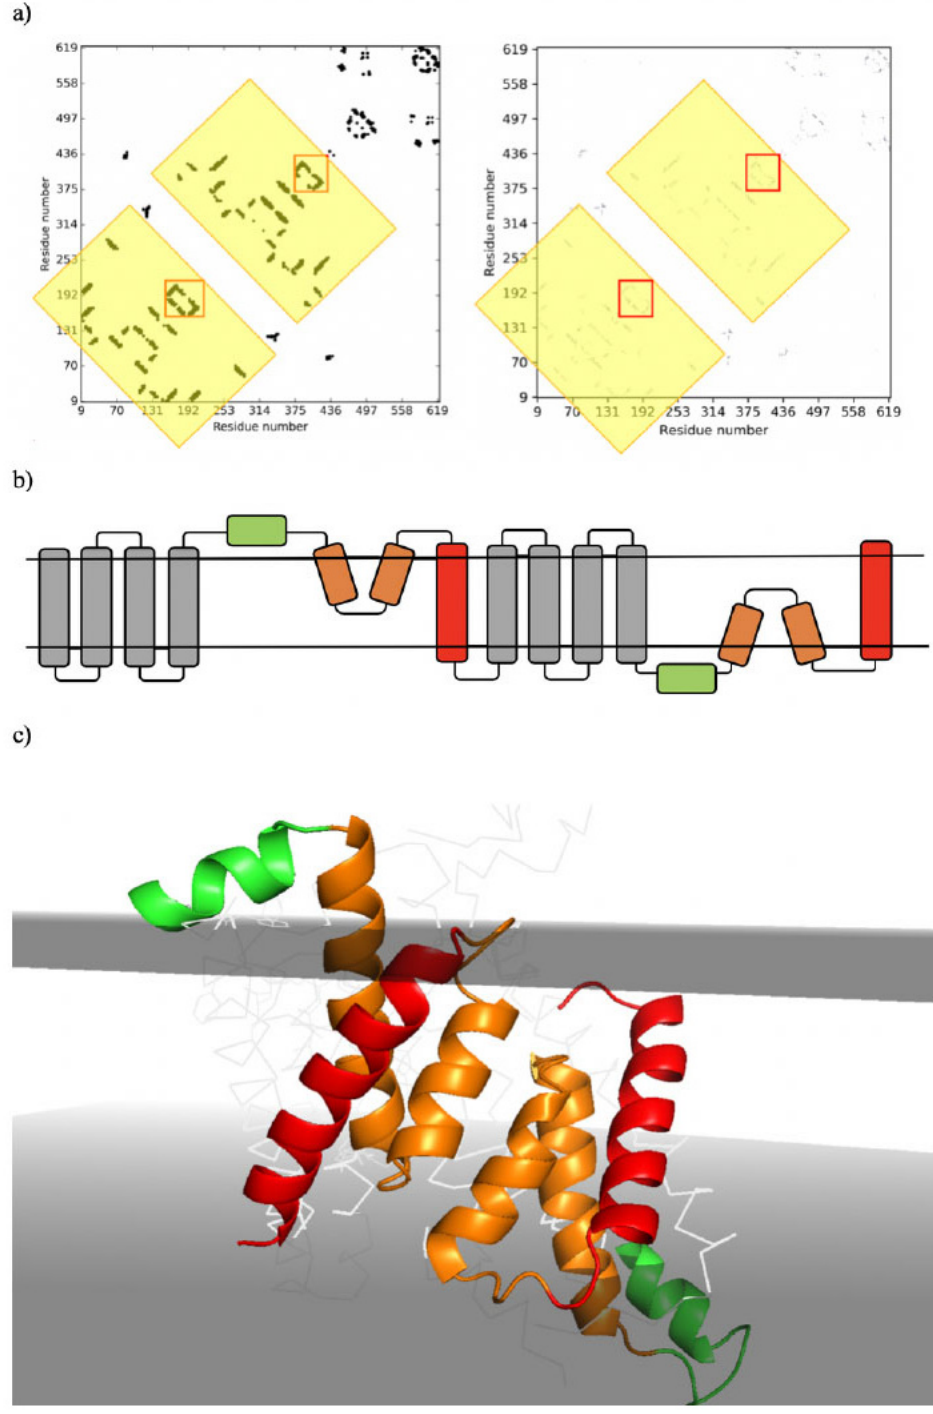
Figure 7. ( a ) Left - Predicted Contact map with repeating units highlighted in yellow boxes, contact map signature of re-entrant loop packed with TM helix in red boxes.; Right - The Experimental Contact map obtained from the PDB structure with repeating units highlighted in yellow boxes, contact map signature of re-entrant loop packed with TM helix in red boxes. ( b ) Actual 3orgA topology; grey: TM Helices that are additional to the core; red: TM helices contributing to the formation of the core; orange; re-entrant loops contributing to the formation of the core; green: amphipathic helices contributing to the formation of the core. ( c ) The 2-fold pseudo symmetry of the amphipathic/re- entrant loop/TM helix core inverted repeat structure of 3orgA with membrane positions shown as grey planes obtained from PDBTM.